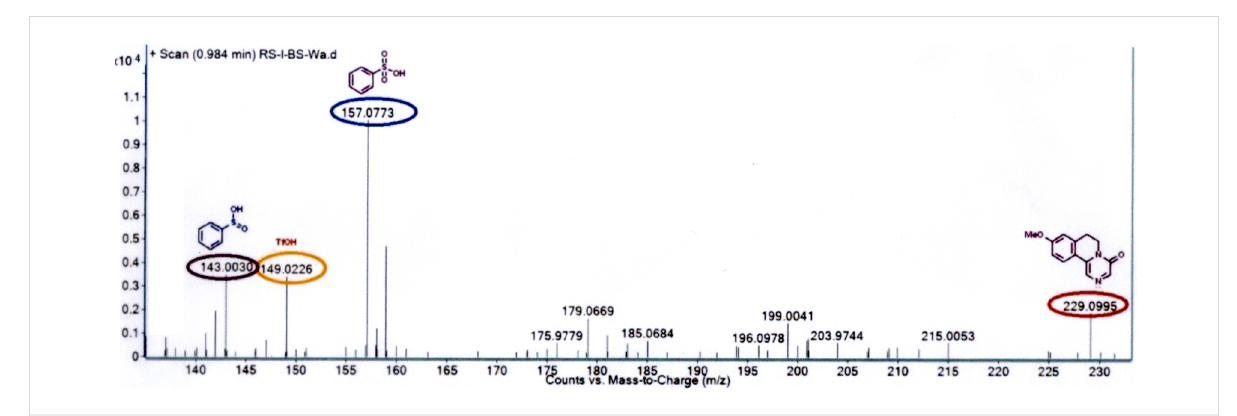
Figure 2: HRMS spectra of aliquot generated from cyclization reaction of 7c